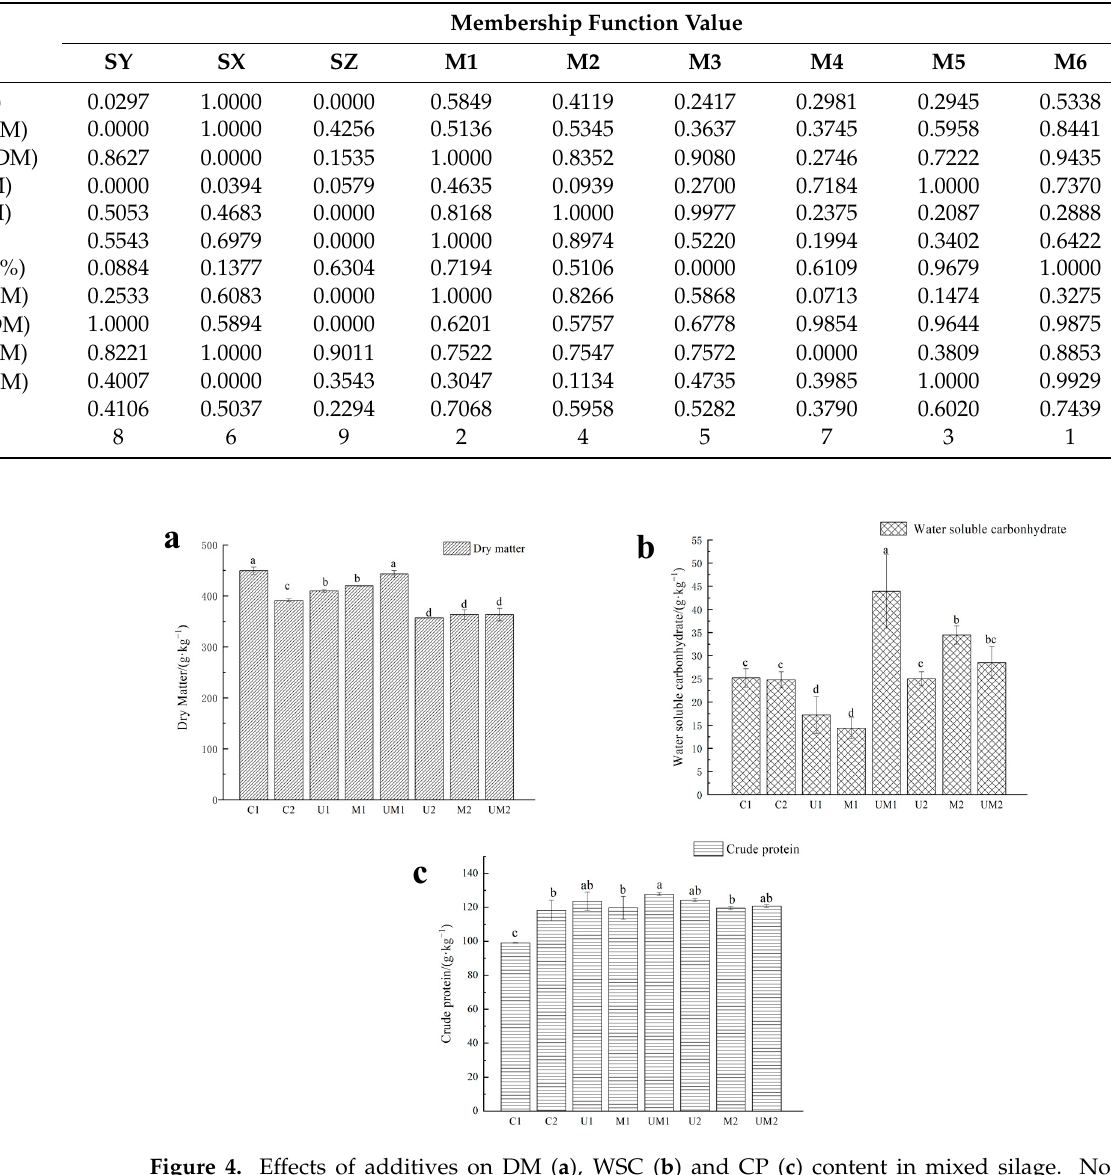
Table 8. Membership function value and comprehensive ranking.